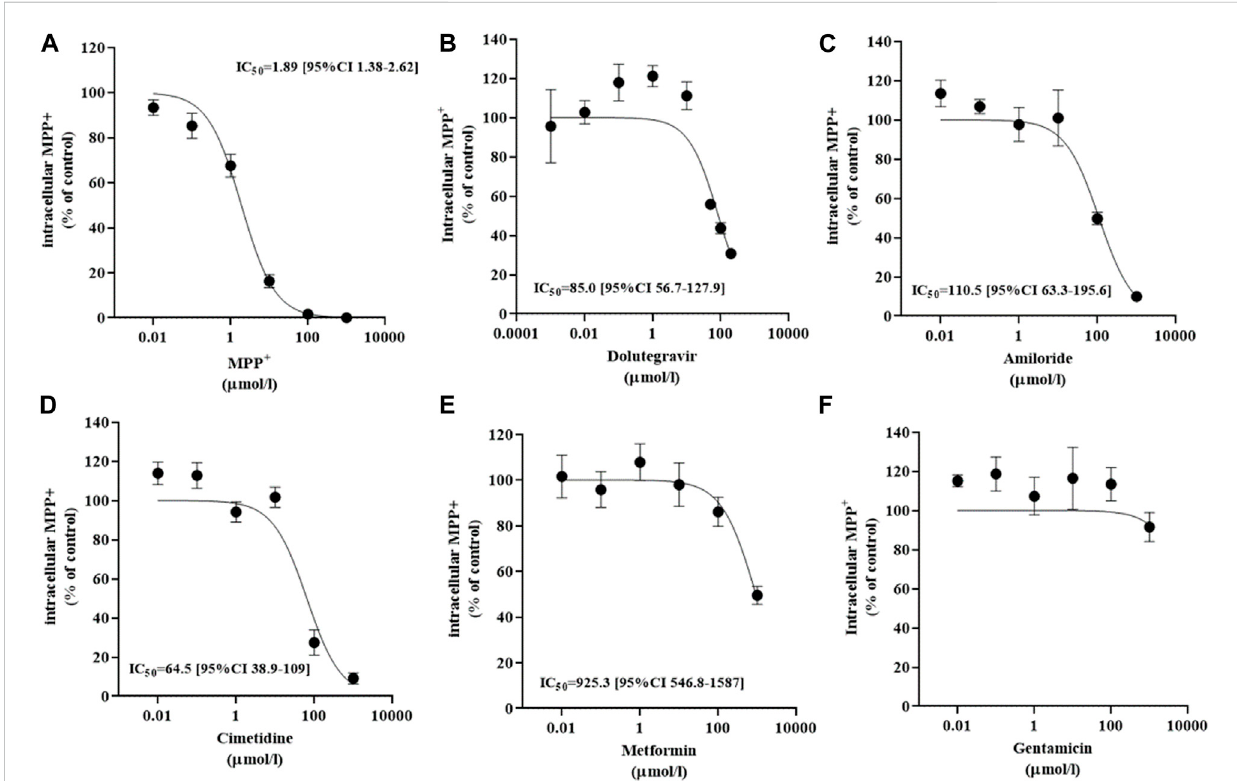
FIGURE 2 Inhibition of MPP + uptake mediated by OCT2. In fl ux of MPP + at an extracellular concentration of 0.5 µM in OCT2-HEK293 cells in the presence of increasing extracellular concentrations of MPP + (A) , dolutegravir (B) , amiloride (C) , cimetidine (D) , metformin (E) , and gentamicin (F) . The uptake value measured in OCT2-HEK293 cells in the presence of the highest extracellular concentration of non-labelled MPP + was subtracted to de fi ne the OCT2- speci fi c transport. Data are expressed as percentage of the control and represent the mean ± SD from at least two independent experiments performed in duplicate. The IC 50 values were computed from a variable slope model of the log (inhibitor) vs response